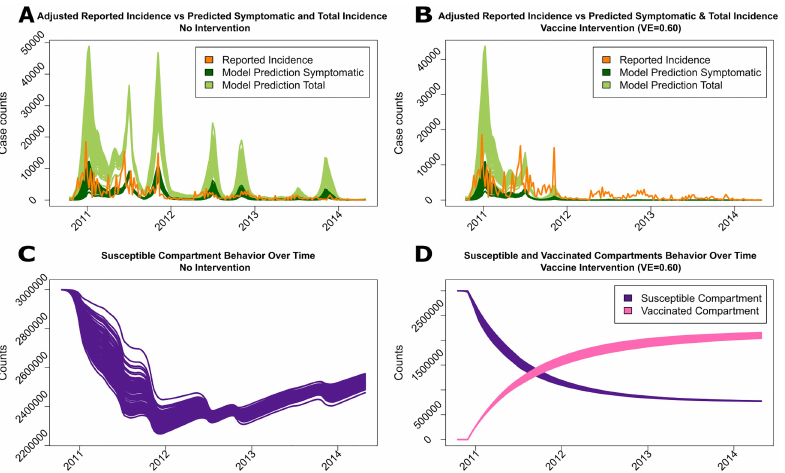
Fig 2. The upper panelsshow the observedincidenceof symptomatic cholera cases adjusted for under- reporting(orange),the model-fitted incidenceof symptomatic cases (dark green), and both symptomatic and asymptomatic infections(light green) from October 2010 to April 2014, without (A) and with (B) vaccine intervention initiatedon November 17, 2010 (five weeks after the onset of the epidemic). The numbersof susceptible (purple) and vaccinated (pink) individualsare shown in the lower panels, without (C) and with (D) vaccine intervention. The averagewaiting time for a susceptibleindividual to be vaccinatedis 50 weeks, the vaccine efficacy is 60%, and the averagedurationof protective immunity is three